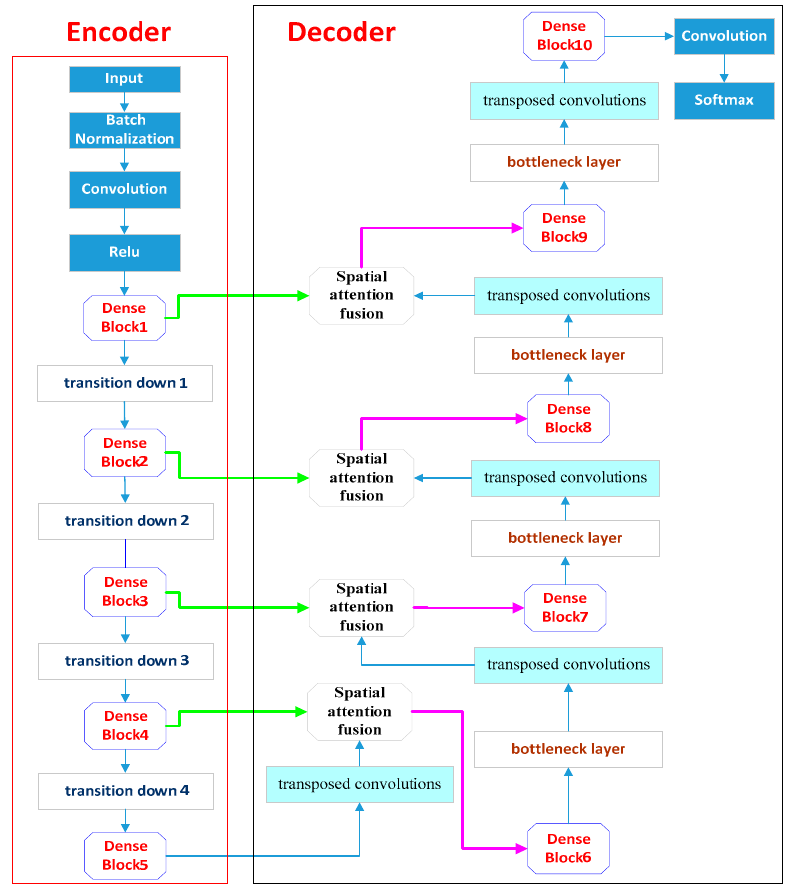
Figure 1. Diagram of overall architecture of dense-attention networks.